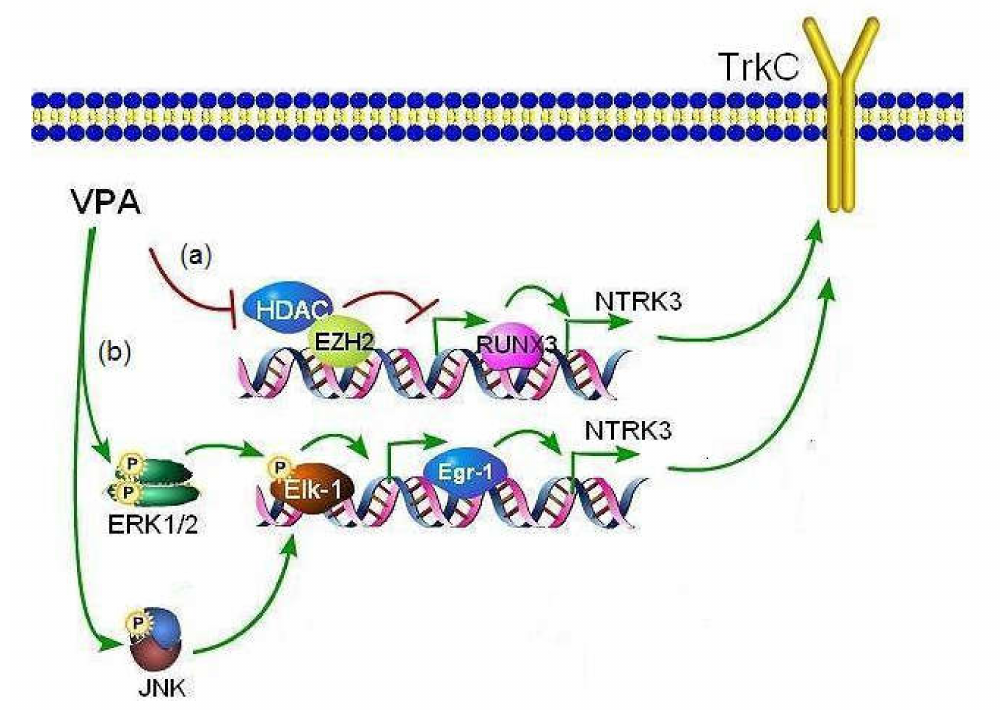
Figure 9. Putative molecular mechanisms mediating the induction of TrkC expression by VPA in human neuroblastoma cells. The diagram illustrates that VPA enhances the expression of the NTRK3 gene encoding TrkC through the following mechanisms: ( a ) epigenetic changes involving RUNX3 derepression as the consequence of HDAC inhibition and EZH2 depletion [32,42]; ( b ) activation of ERK1/2 and JNK signaling pathways. ERK1/2 activation exerts a major stimulatory input on NTRK3 activation by inducing Egr1 expression likely via Elk-1 phosphorylation. The stimulation of JNK appears to provide a minor contribution possibly by participating in Elk-1